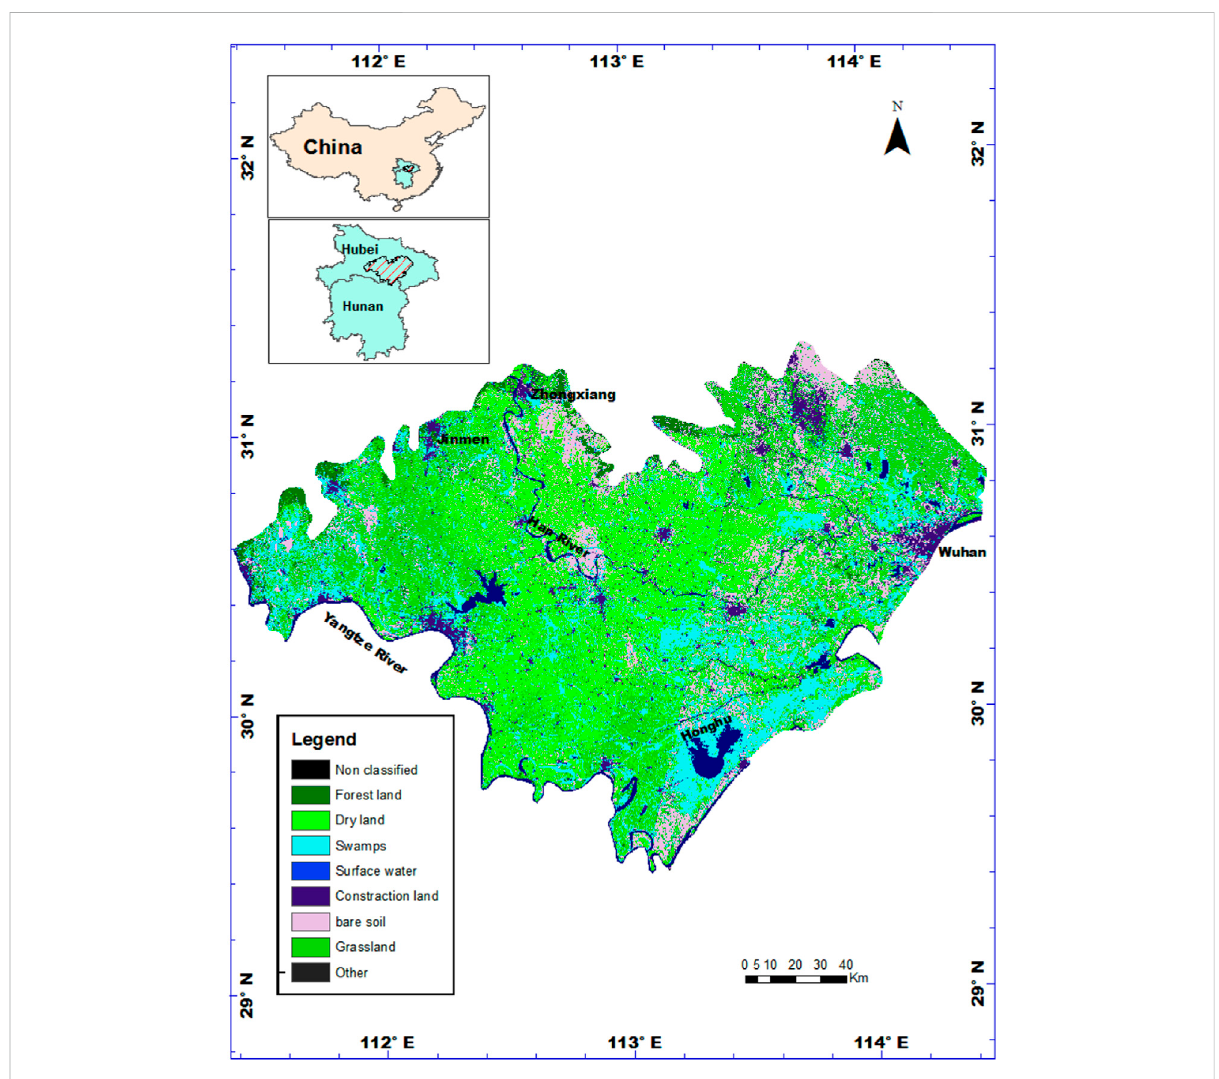
FIGURE 1 Location of the selected study area in Hubei province (Jianghan